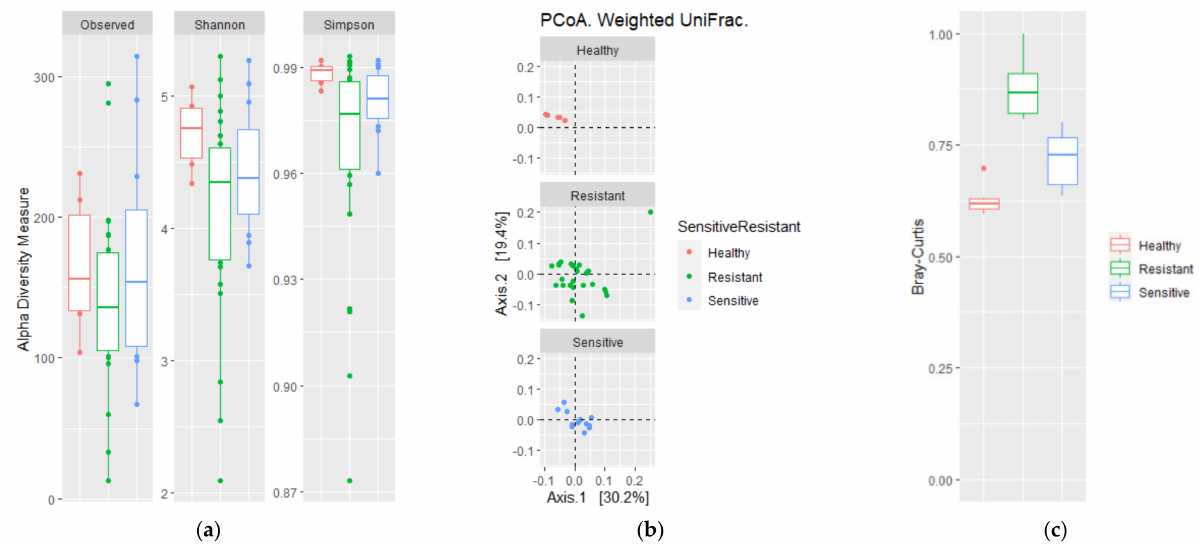
Figure 3. Comparison of alpha and beta diversity of drug-sensitive and drug-resistant TB patients. ( a ) Alpha diversity based on the number of observed species and Shannon and Simpson diversity; ( b ) PCoA weighted UniFrac; and ( c ) Bray–Curtis dissimilarity index. Plots represent HV samples (red symbols), drug-resistant TB patients (green), and drug-sensitive TB patients (blue). Statistical significance between groups is indicated by ( p < 0.05). Wilcoxon and ADONIS tests for alpha and beta diversity comparisons, respectively, were